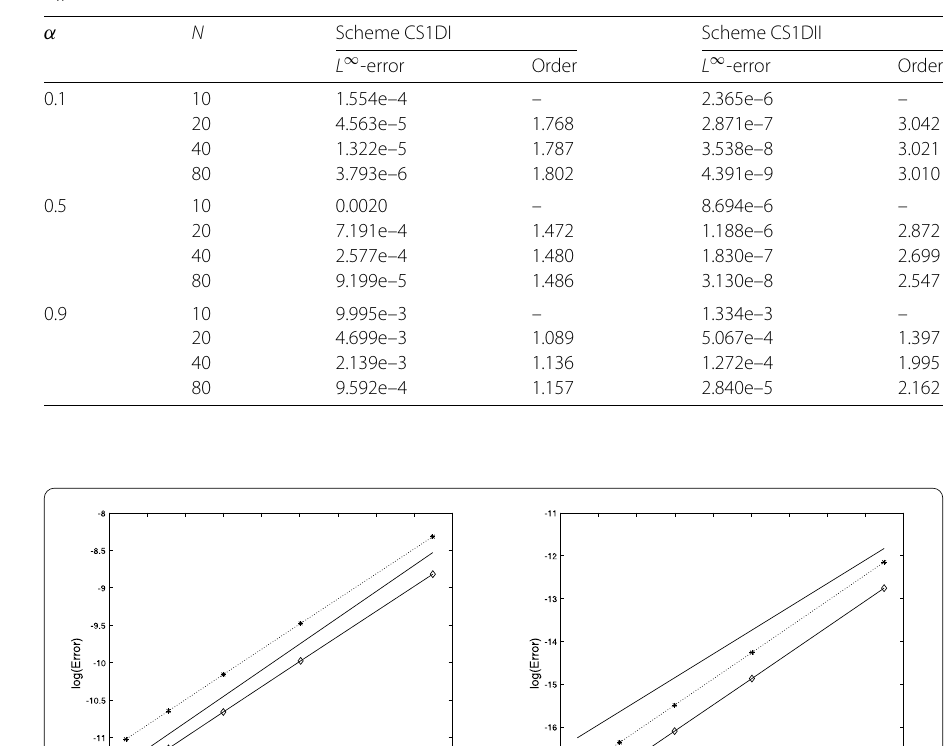
Table 2 Numerical comparison results of schemes CS1DI and CS1DII for Example 1, at T = 1 with N x = 2000 and different N and α